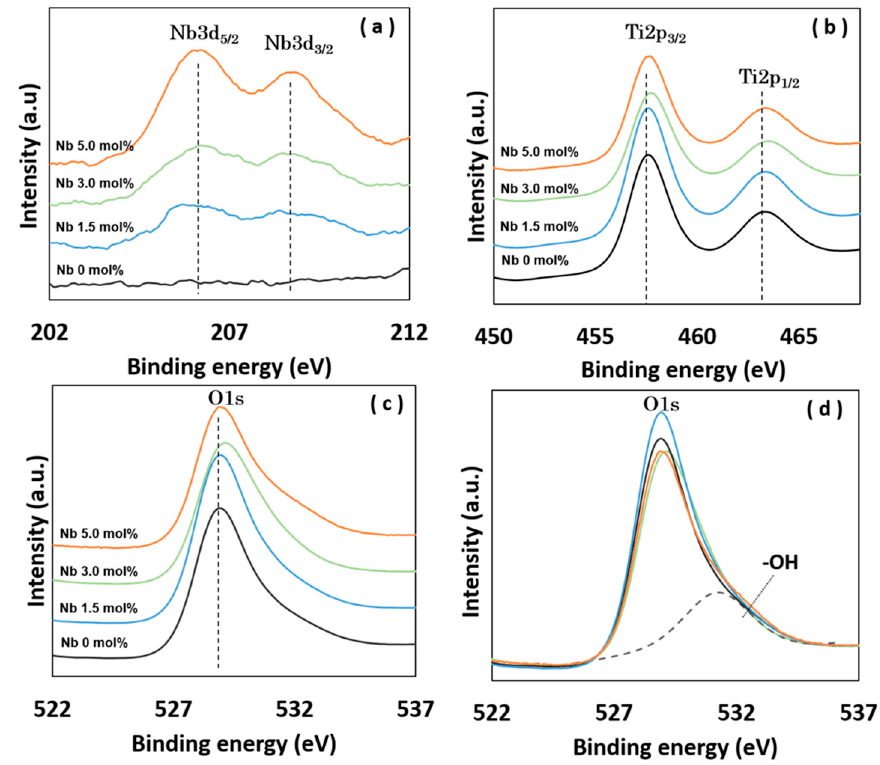
Figure 2. High-resolution ( a ) Nb 3d, ( b ) Ti 2p, and ( c ) O 1s X-ray photoelectron spectroscopy (XPS) spectra of TiO 2 with varying Nb contents. ( d ) O 1s spectral fitting, revealing the presence of peaks related to OH groups.